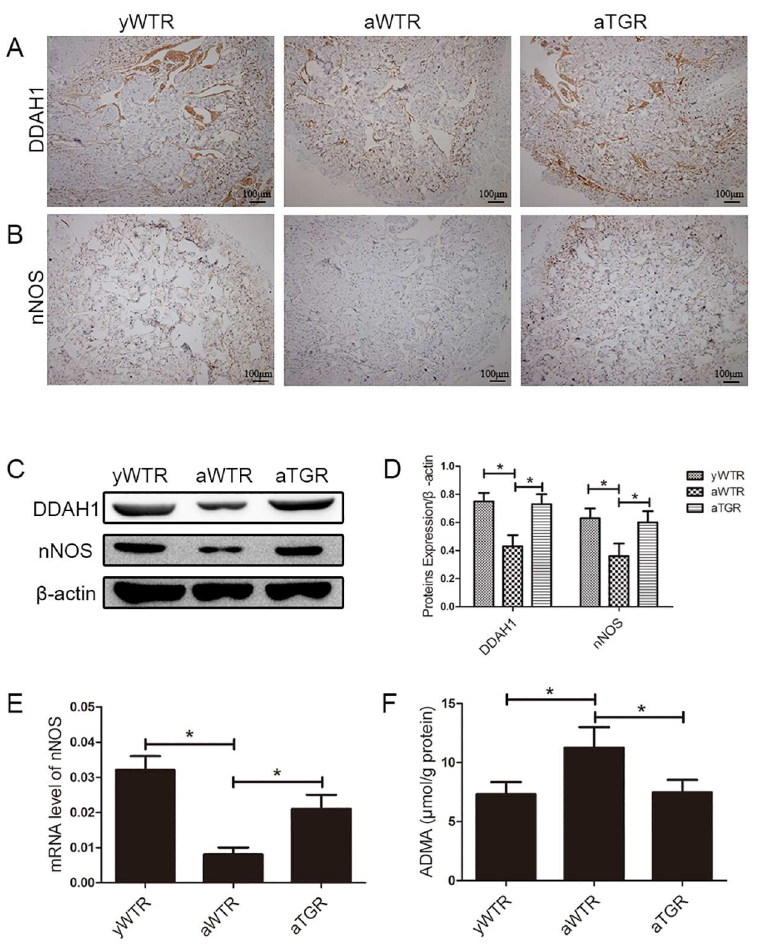
Fig 3. Expression levels of DDAH1, nNOS and ADMA. (A) and (B): Immunohistochemistry results of expressions of DDAH1 and nNOS (magnification × 100). (C): Representative western blot results of DDAH1 and nNOS in corpus cavernosumof three groups. (D): Expressions of DDAH1 and nNOS with β -actinas the loadingcontrol in the corpus cavernosum of three groupswere presented through bar graphs. (E): nNOS expressionlevel with β -actinas the loadingcontrol in peniletissues of all groups by real-time RT-PCR using the 2- Δ Ct method. (F): ADMA concentrations of all groups assessedby ELISA method. The data are expressedas mean ± s.d. * P < 0.05when comparing the two groups under each end of the capped